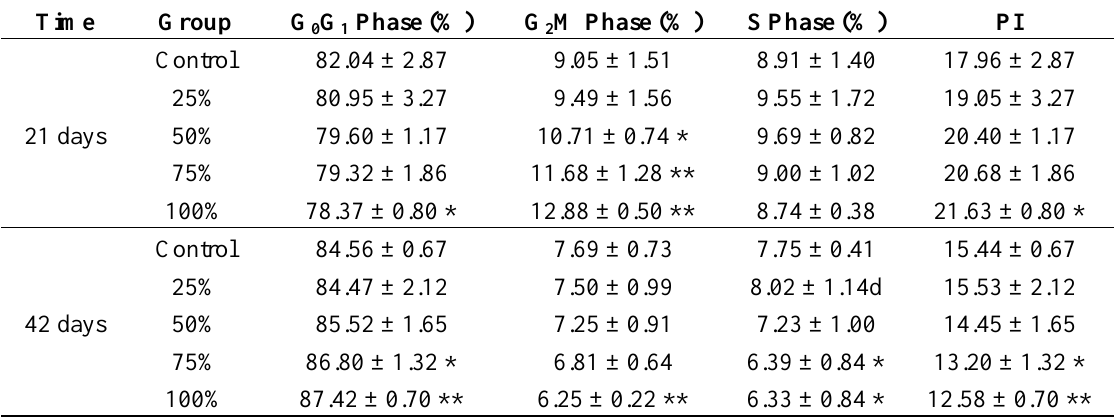
Table 2. Effect of AFB-contaminated corn on cell cycle phase distribution of spleen in chickens.